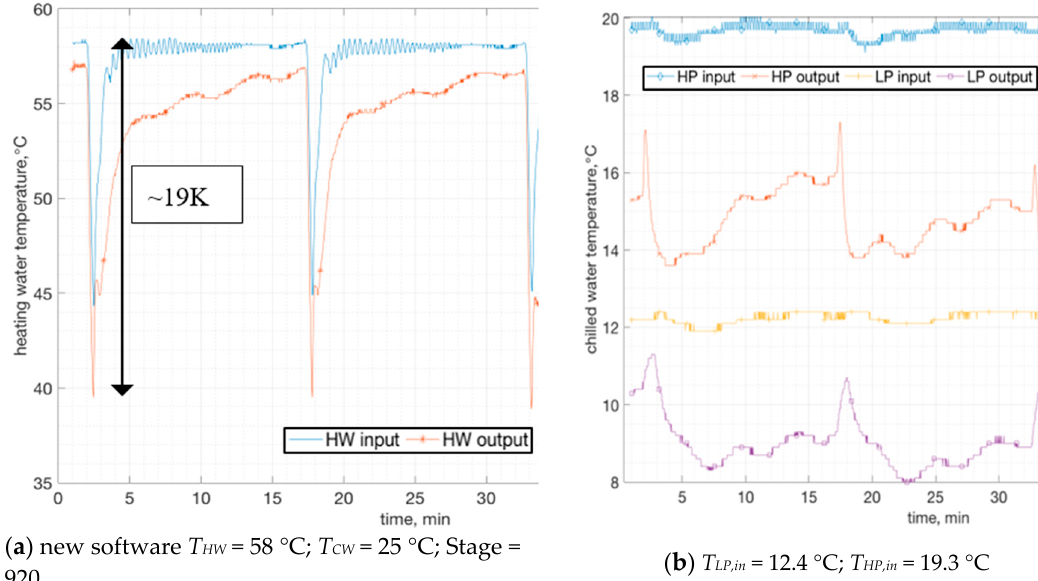
Figure 8. Examples of the inlet and outlet temperatures of the heating and chilled water registered during the operation of the chiller under the original control system. ( a ) and ( b ) were registered during the same time period. ( a ) Hot water inlet and outlet, ( b ) Low and high pressure.